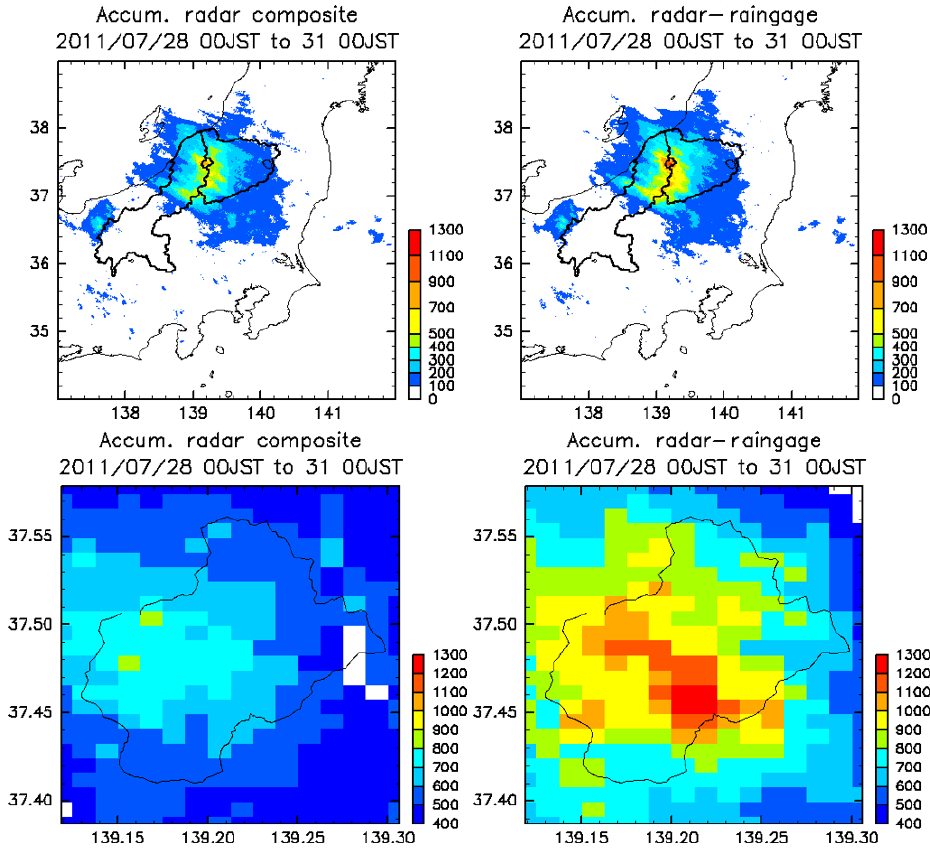
Figure 5. Spatial patterns of cumulative rainfalls around the Shinano and Agano catchments using radar composite (upper left) and radar–rain gauge (upper right) and around the Kasahori dam catchment using radar composite (lower left) and radar–rain gauge (lower right) for the 2011 rainfall